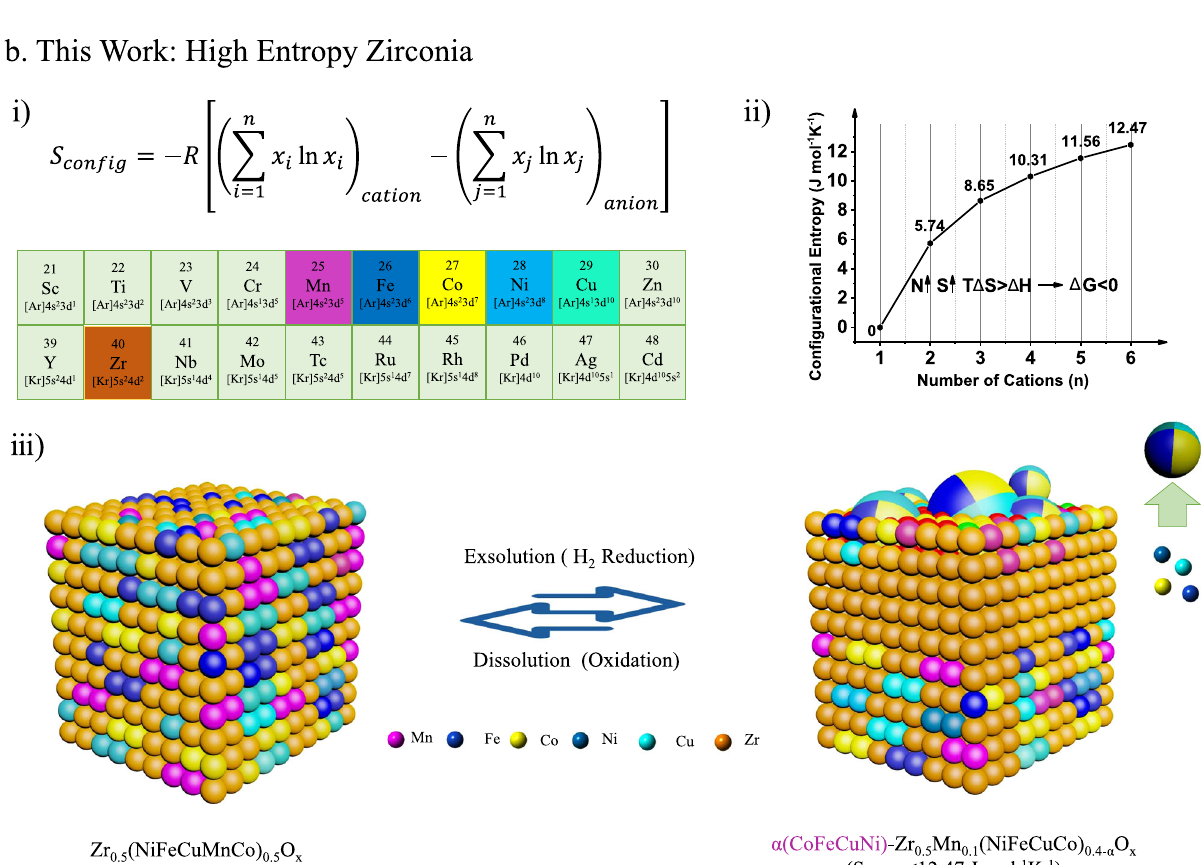
Fig. 1 Comparison of self-regenerative materials. a Representative perovskite-based self-regenerative materials. b i. The con fi gurational entropy formula, and the selected metals for high entropy ZrO 2 . ii. Calculated values of con fi gurational entropy for Zr 0.5 (M 1 -M n ) 0.5 O x , n = 1 – 5 (for example, n = 2, Zr 0.5 (M 1 M 2 ) 0.5 O x ). iii. Schematic representation of in situ exsolution and dissolution of CoFeCuNi alloys in the Zr 0.5 (NiFeCuMnCo) 0.5 O x during redox processes. For simple, oxygen ions were